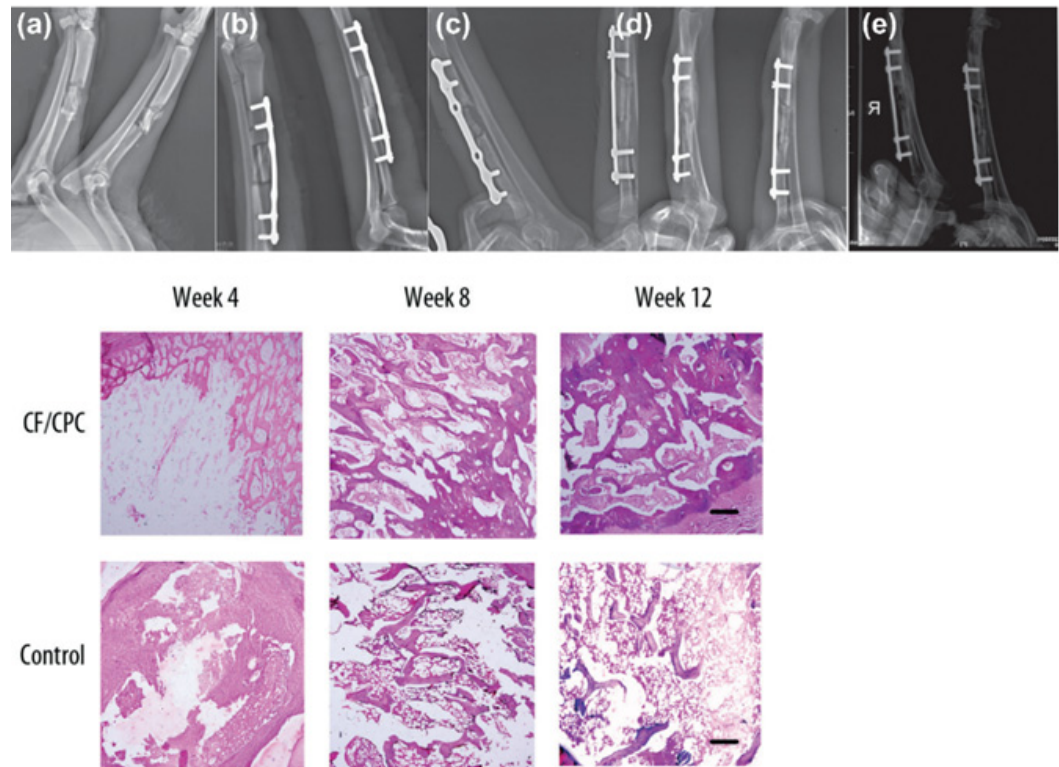
Figure 4. Chitosan fiber and calcium phosphate ceramics (CF/CPC) scaffold for fracture repair in weight-bearing long bones (radiuses) [61]. Upper panel: ( a ) X-ray images of both radii in adult dogs, right radius received CF/CPC scaffold, left radius were untreated (blank control). Radiographic images post-implantation at various time points in the experimental group: ( b ) 0 weeks, ( c ) 4 weeks, ( d ) 8 weeks, ( e ) 12 weeks. Lower panel: Histological examination of the bone-defect area tissue at 4-, 8-, and 12 weeks after surgery. The experimental group showed time-dependent slow resorption of cement and the formation of new bone tissues. In contrast, no biological activity occurred in the control group.